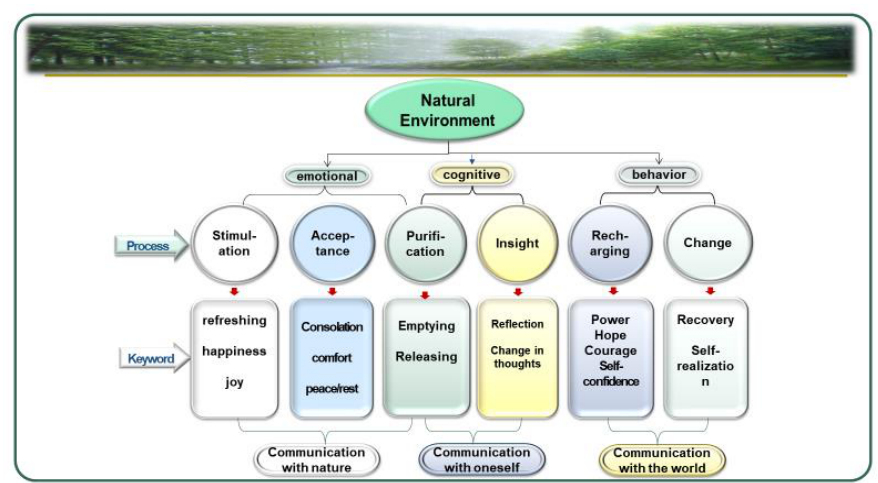
Figure 1. Six-Step Model of Nature-Based Therapy